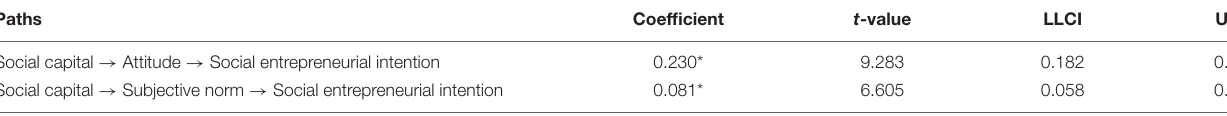
TABLE 4 | Results of bootstrap analysis. Paths